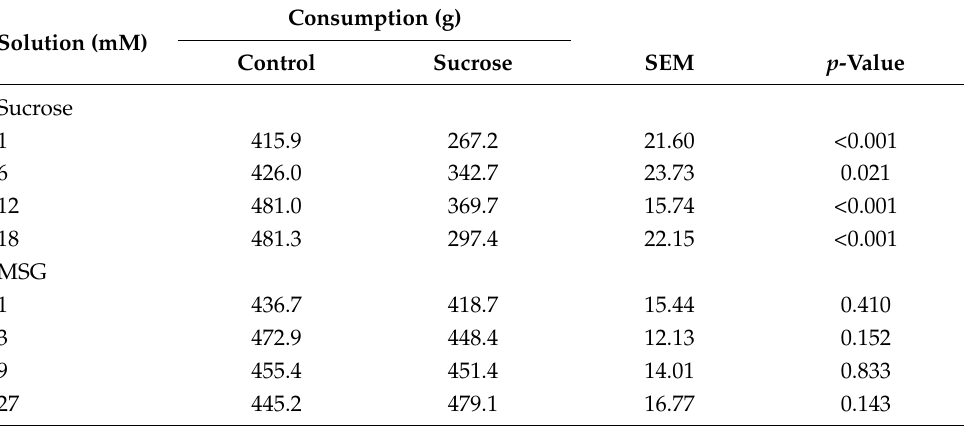
Table 2. Consumption of pigs from control and sucrose groups for sucrose and MSG 1 solutions.